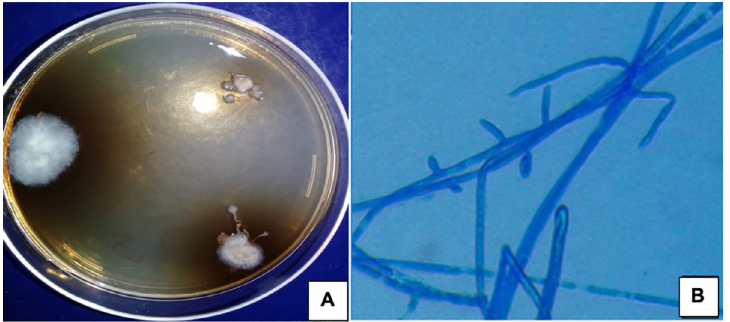
Fig 3. Cultures on Sabouraud dextrose agar showing dry colonies, white with a greyish surface mycelium and a diffusible brown pigment (A). The microscopic features of the colonies displayed septate hyphae with branched conidiophores bearing pyriform conidia ( ×